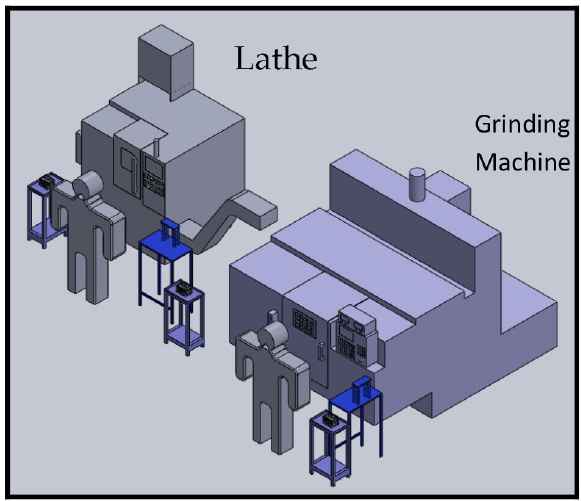
Figure 4. Linear distribution of the lathe process and grinding